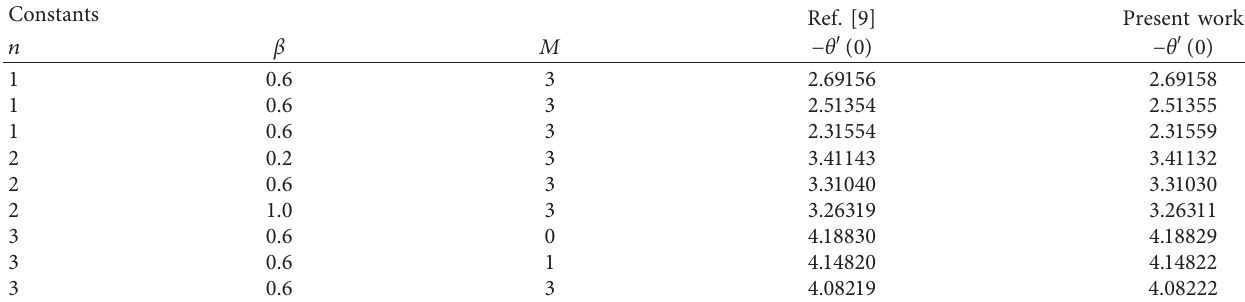
� λ � 0 , Nt � Nb � 0 . 5 , Pr � 7. w